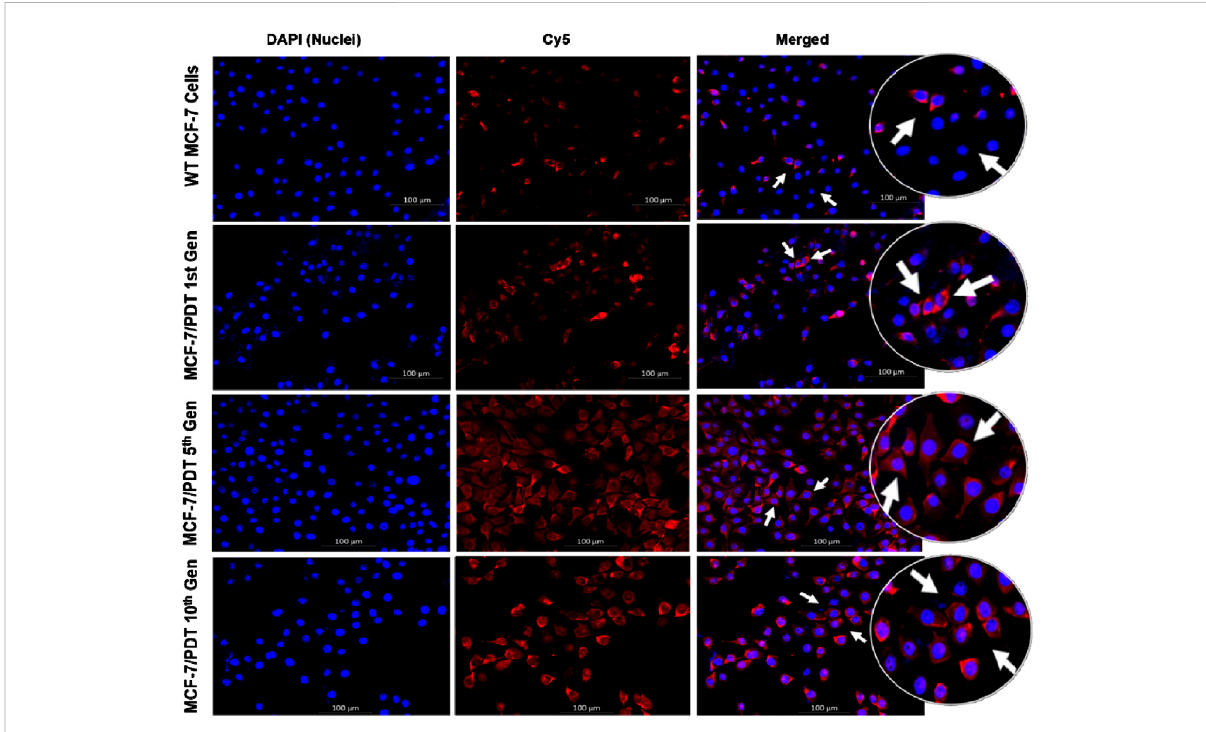
FIGURE 3 Immuno fl uorescence expression of P-gp in both WT and MCF-7/PDT cells. The cell nuclei were stained blue, and P-gp was stained with cy5 (red).